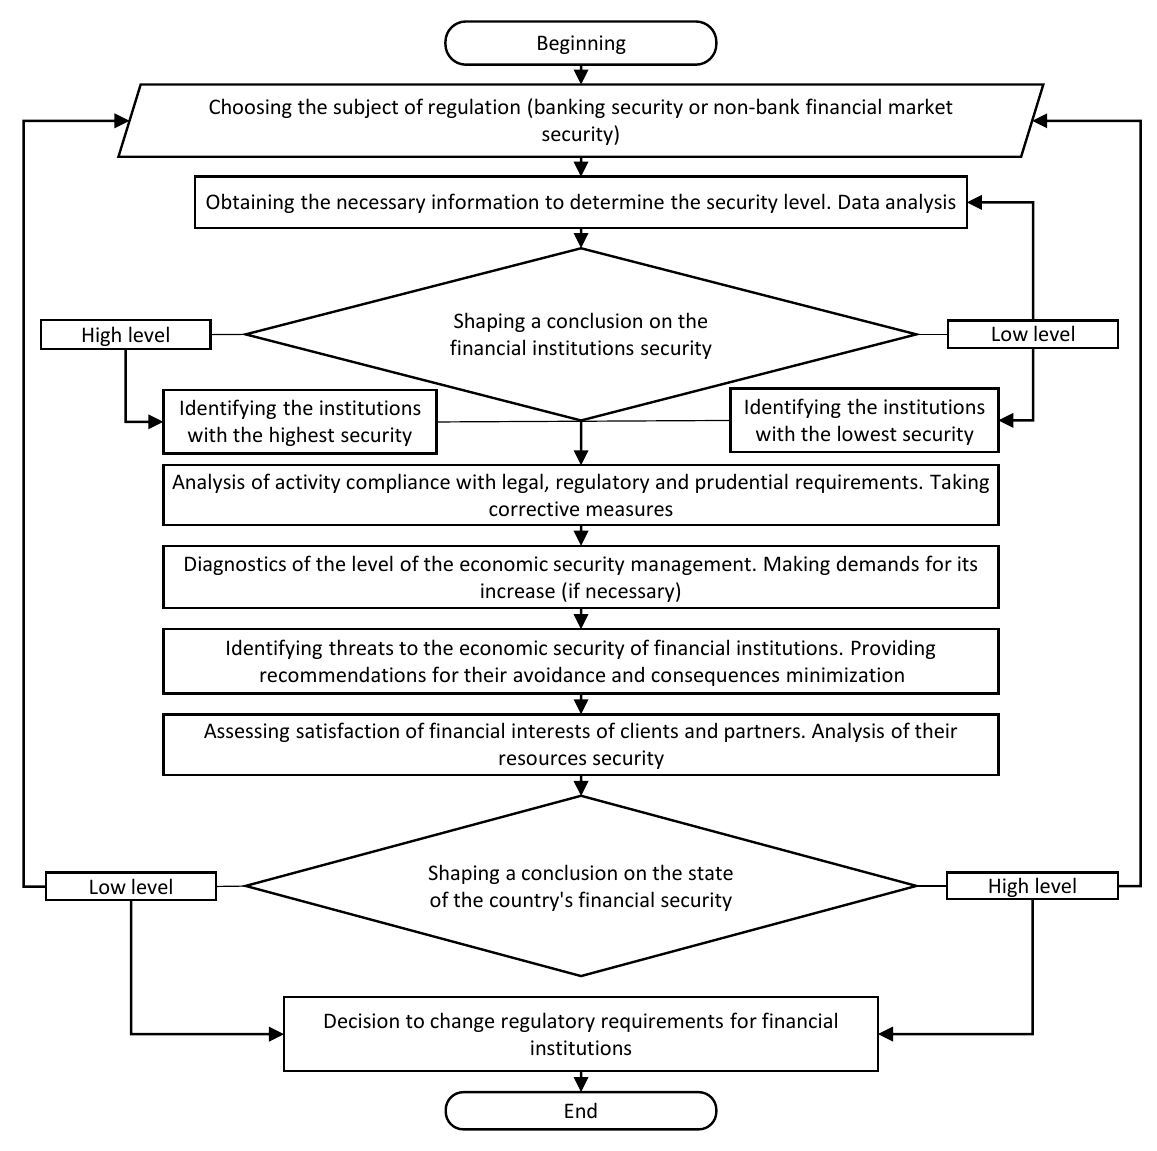
Figure 3. Position of managing the economic security of financial intermediaries in the